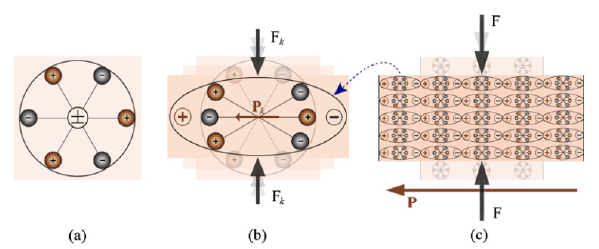
Figure 1. Piezoelectric: (a) No Piezoelectric Polarization (b) The Molecule Subjected to an External Force (c) The Polarization Effect on the Surface.